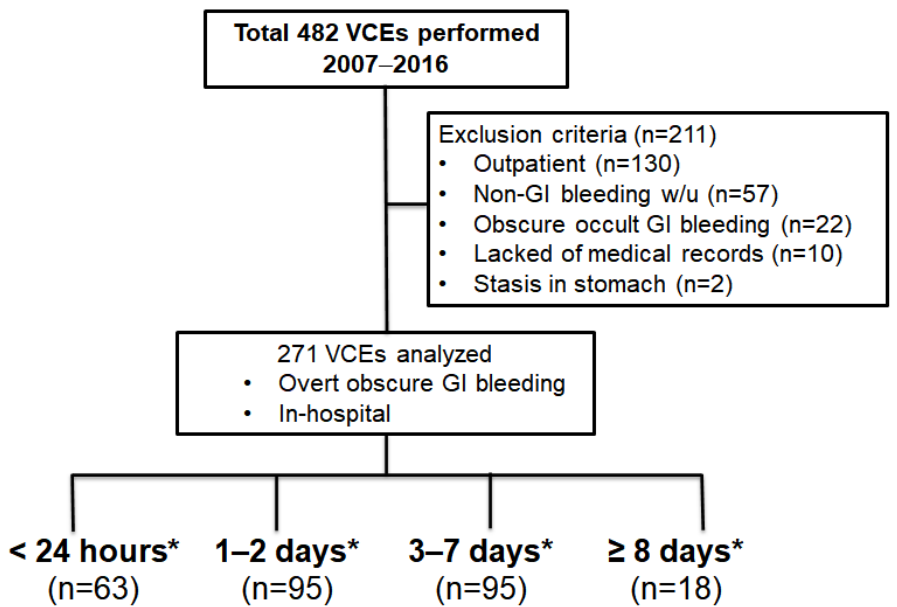
Figure 1. Study flow. * Time interval = VCE − the latest GI bleeding ; VCE, video capsule endoscopy; GI, gastrointestinal.